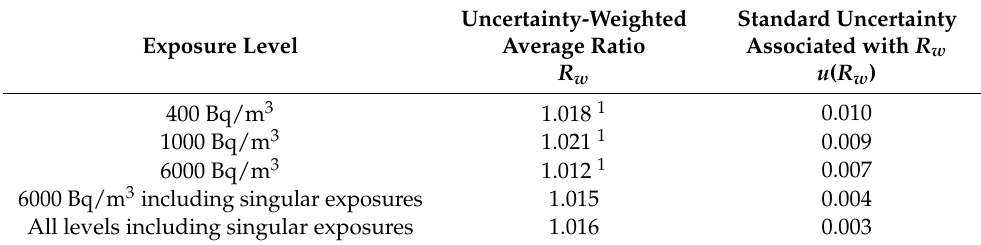
Table 4. Uncertainty-weighted average ratio and its standard uncertainty for the different exposure